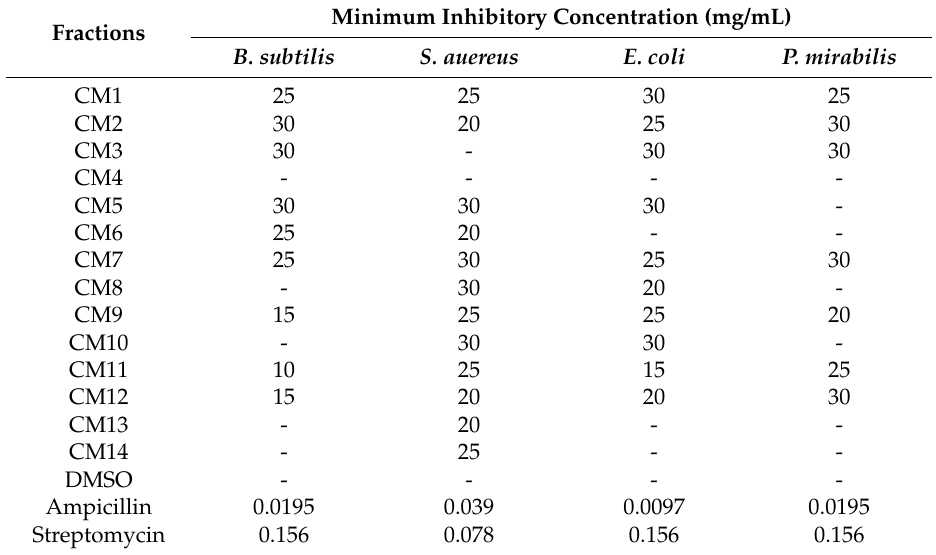
Table 3. Antibacterial activity in term of MIC values of EtOAc fractions isolated from C. militaris